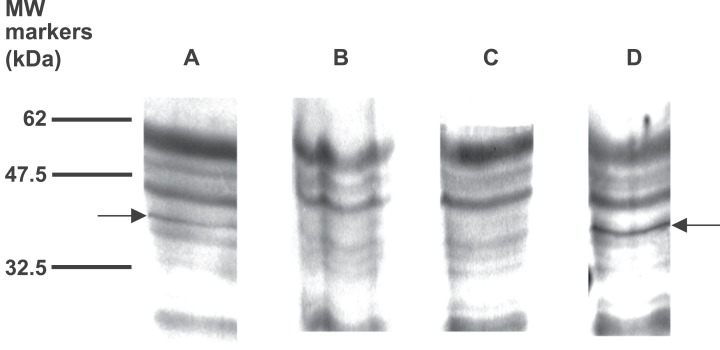
Western blot of aqueous extract of rat hypothalamus, with preabsorption.Samples were analysed by 12% SDS PAGE under non-reducing conditions and then by western blot using the goat polyclonal antibody at a dilution of 1/400 and secondary antibody at 1/5,000. Arrows show a band at 35–45 kDa. (A) Not preabsorbed. (B) Preabsorbed with EPL001. (C) Preabsorbed with KVKEFNNI. (D) Preabsorbed with MKPLTG.